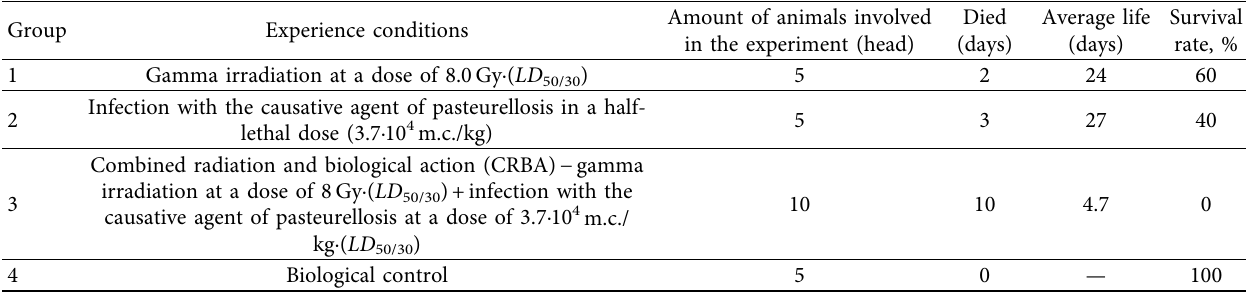
Table 3: Survival rate of rabbits subjected to isolated and combined exposure to physical (gamma irradiation) and biological (infected with P. multocida) factors.